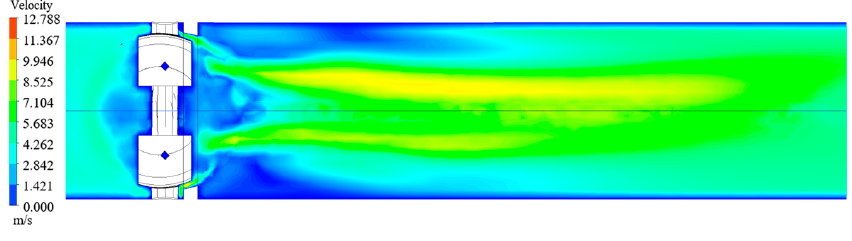
Figure 10. Continuous phase velocity cloud.